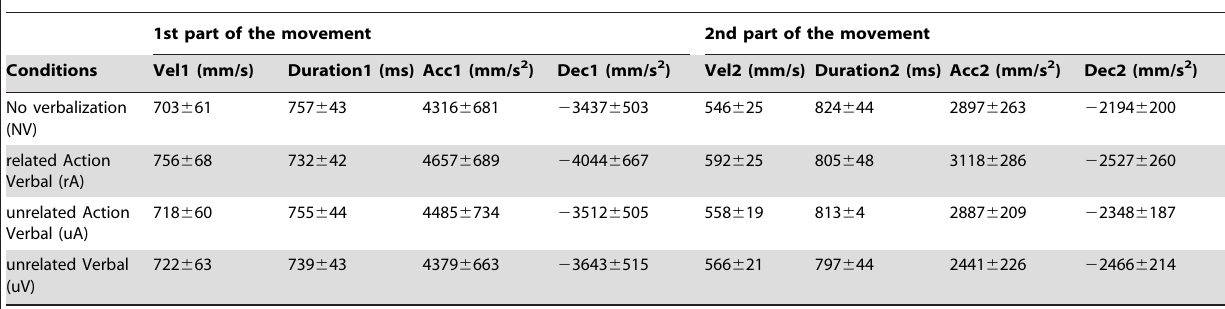
Mean values 6 standard error of the mean (SEM).